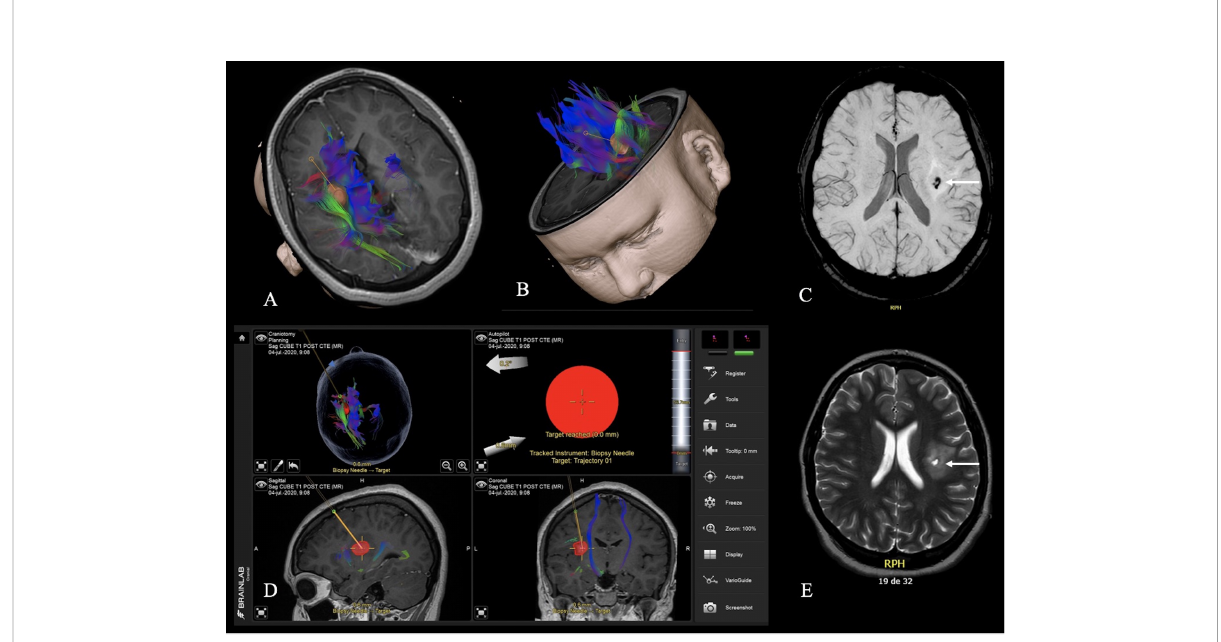
FIGURE 4 3D reconstruction showing a left insular tumor, its relationship with the motor bundle and the arcuate fasciculus, and the biopsy trajectory (A, B) . Screenshot of the planned biopsy tract to the target (D) . Intraoperative MRI with a T2-weighted (E) and SWI (C) as a fi nal control to verify the location of the tumor samples indicated by the arrows and to rule out complications related to the